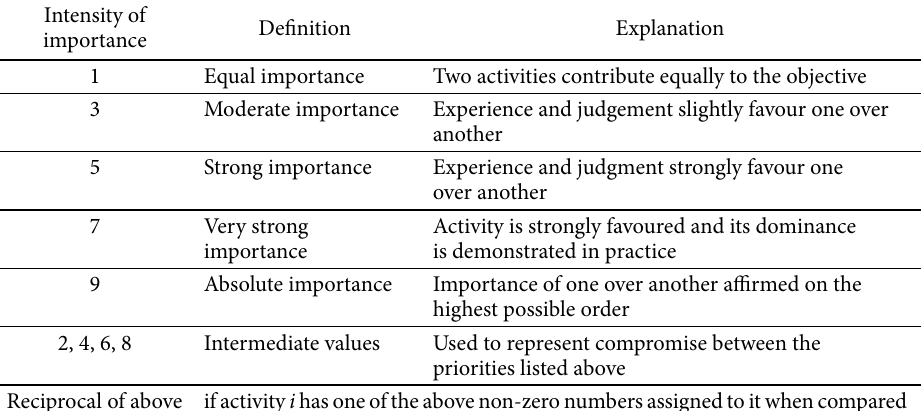
Table 2. Saaty’s 1–9 Scale for AHP Preference (Saaty